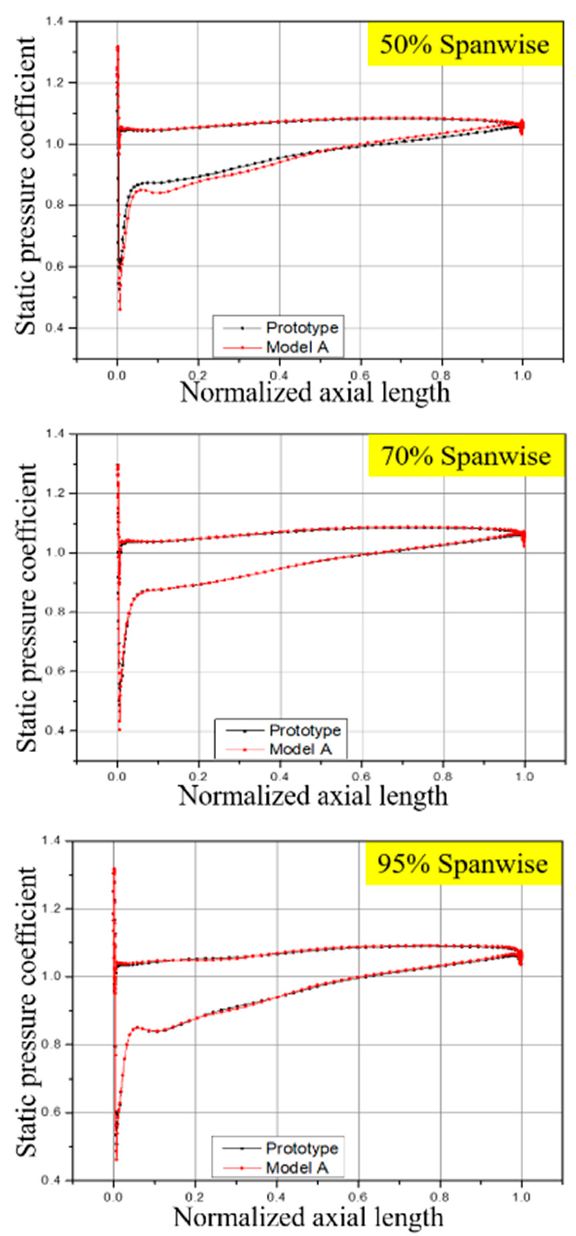
Figure 5. Static pressure distributions of the rotor.